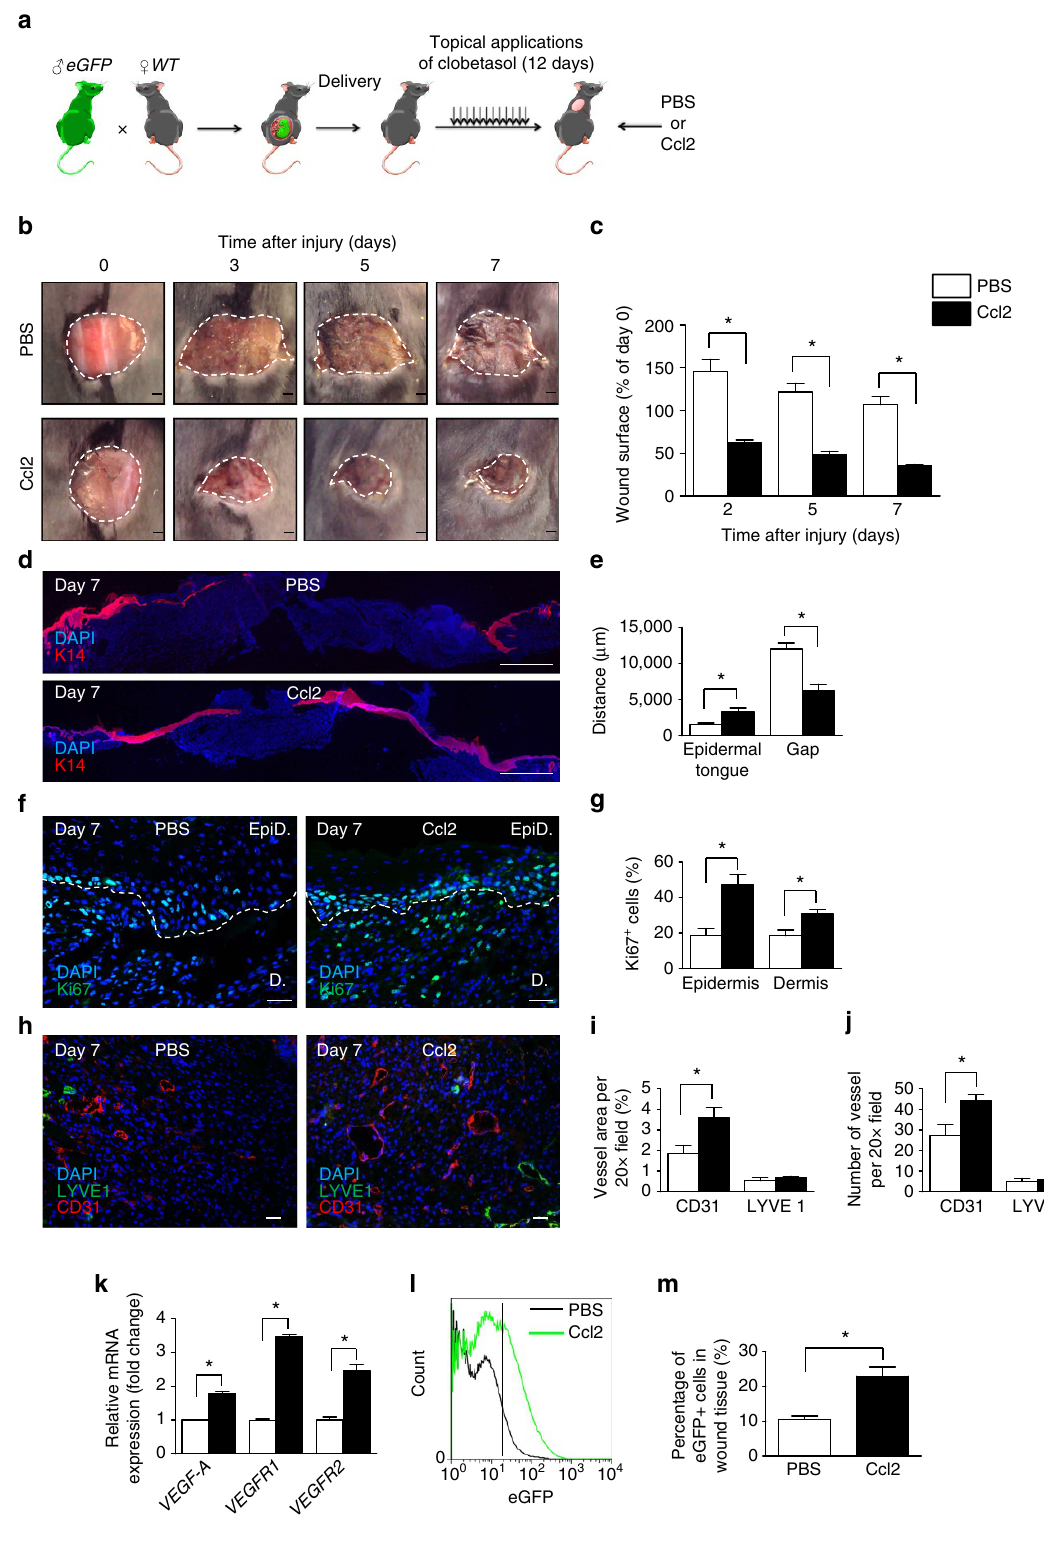
crucial role in neovascularization during skin repair 34 . Foetal progenitors persisting in the adult therefore reach maternal tissues and improve angiogenesis via the formation of new vessels derived from fetal cells and the stimulation of maternal angiogenesis.